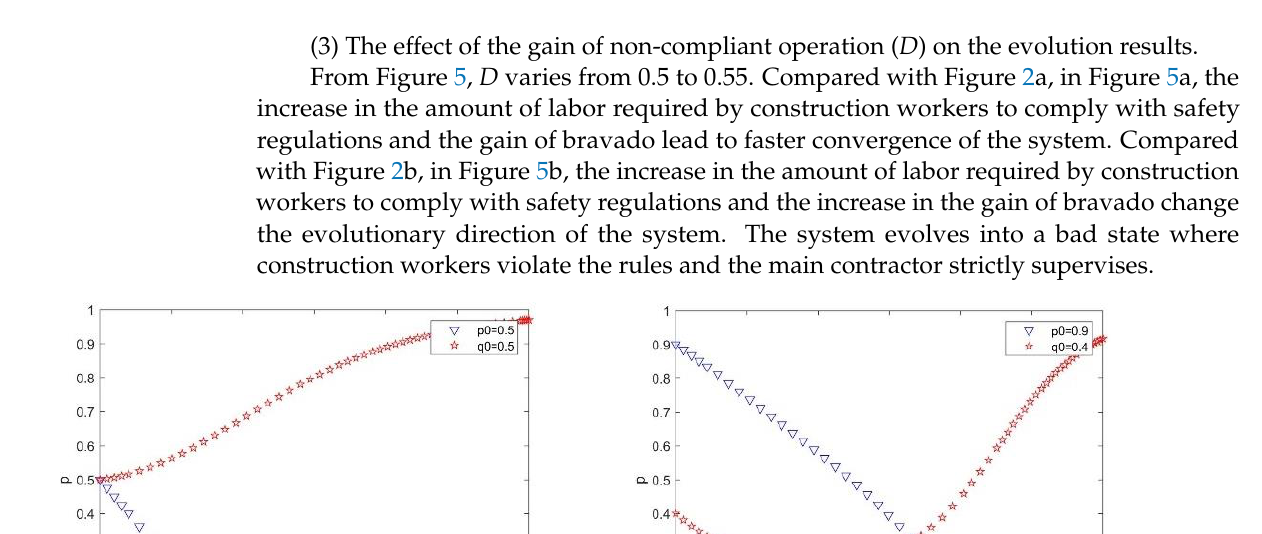
Figure 4. The effect of construction workers’ expected accident loss S 1 on the evolution results.